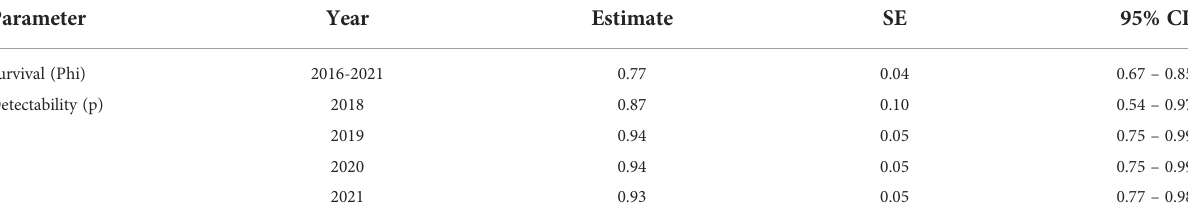
TABLE 3 Averaged parameter estimates for the two models within D AICc ≤ 2 in the CJS analysis to estimate survival and capture